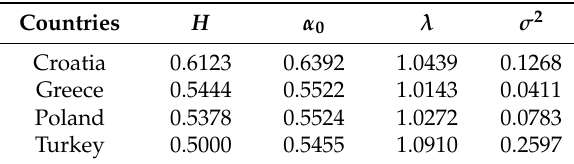
Table 9. MMAR parameters of the original series.